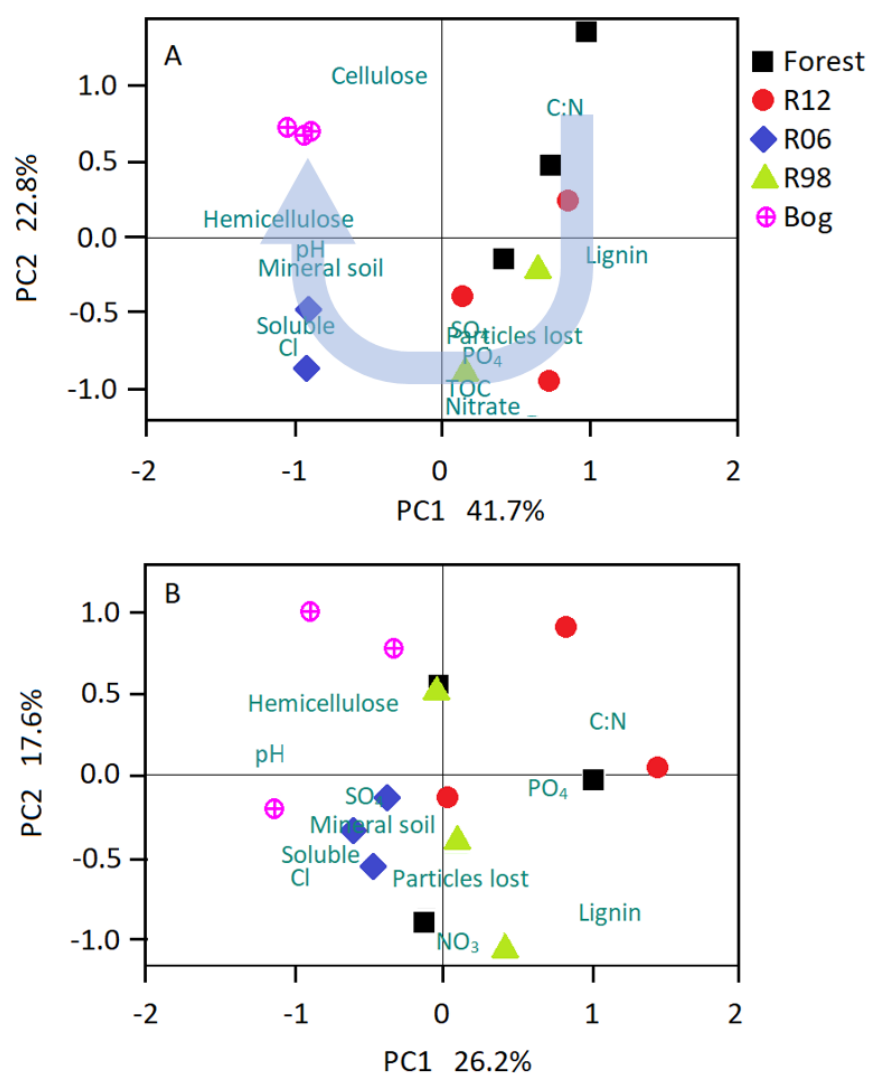
Figure 6. Principle component analysis for (A) shallow cores and (B) deep cores. The blue arrow shows an apparent trend of site clusters according to peat properties from forested sites to intact bogs, with restored sites of increasing age forming intermediate